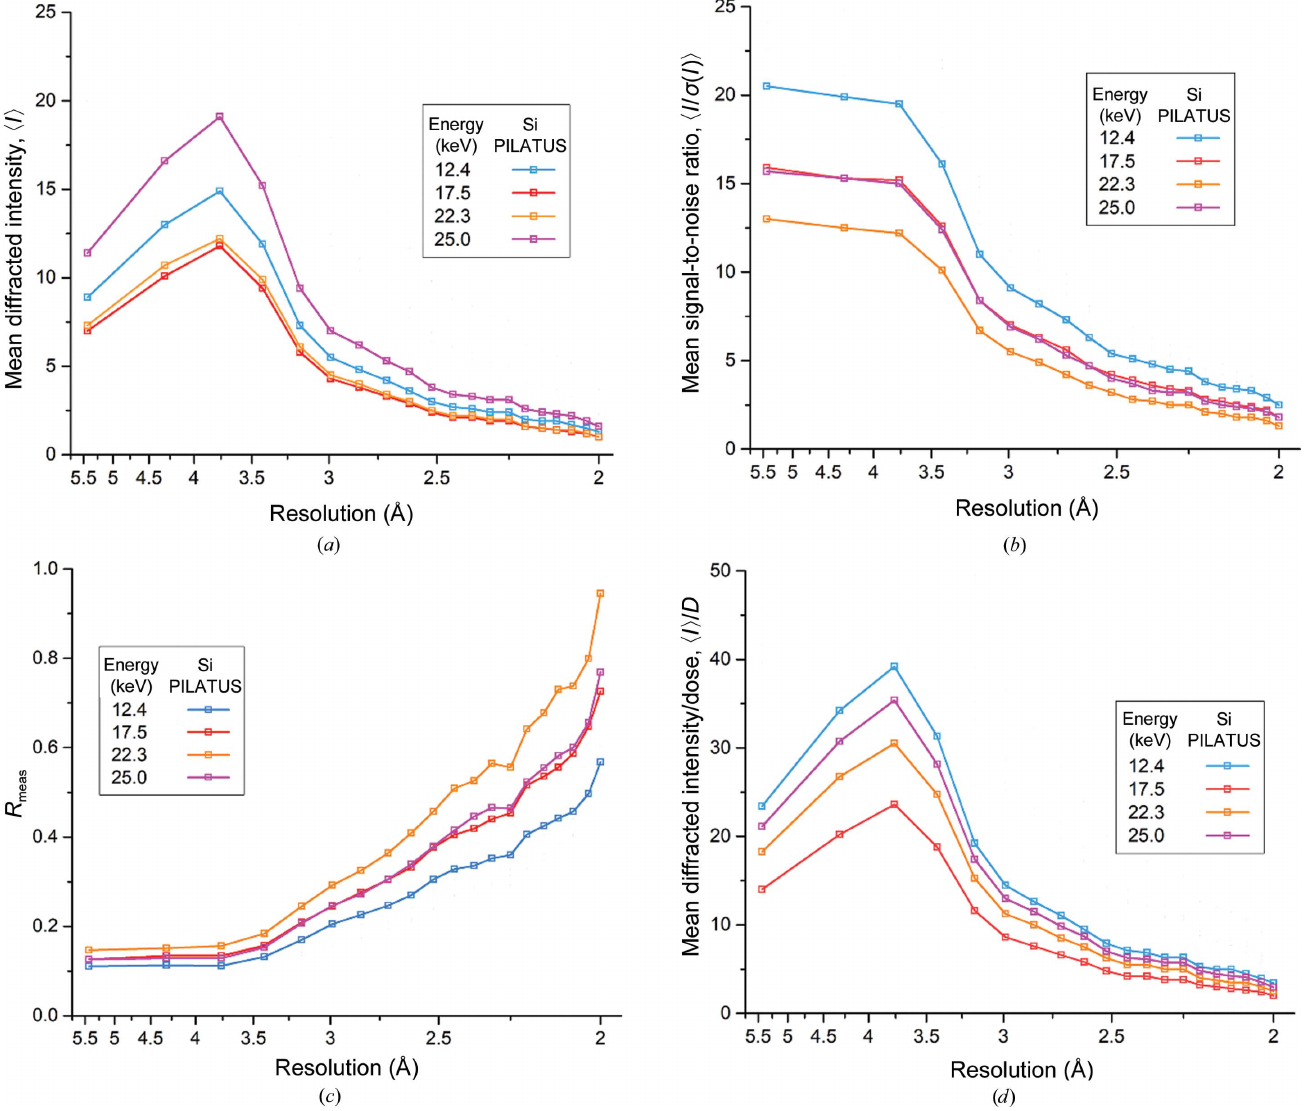
Figure 2 Overview of a data series collected using the Si PILATUS detector, illustrating the impact of higher X-ray energies and detector sensor material. ( a ) shows the mean unscaled intensity per Bragg spot h I i as a function of resolution. ( b ) Mean unscaled signal-to-noise ratio per Bragg spot h I / (cid:6) ( I ) i . ( c ) Multiplicity-independent merging R value R meas . ( d ) Observed mean diffracted intensity per Bragg spot normalized to the absorbed dose, h I i / D . In all panels the data points reflect the high-resolution limit of each shell; the lowest resolution data point includes reflections over the range 40–5.5 A˚